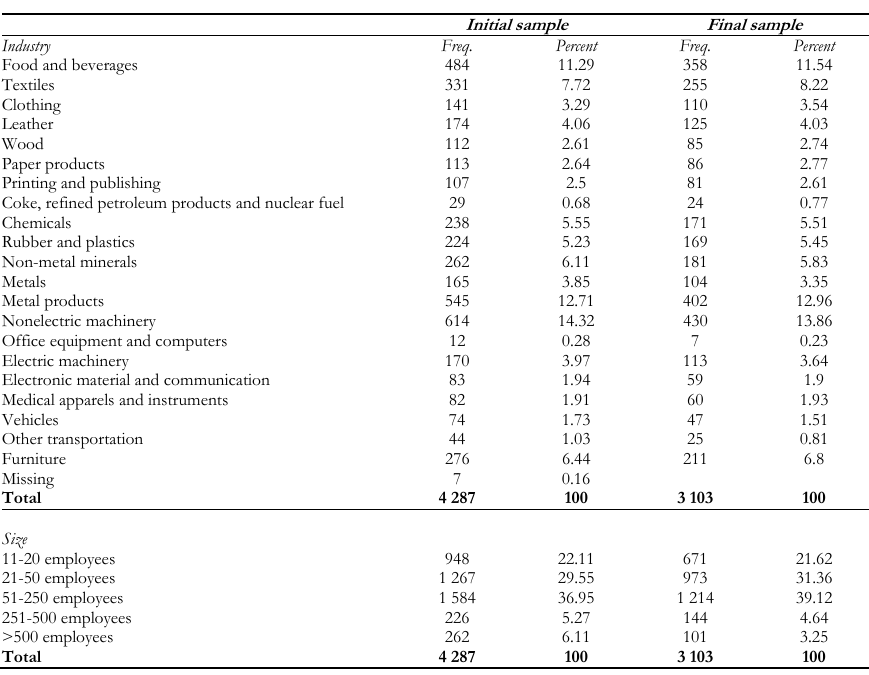
Distribution by industry and size, initial and final sample Initial sample Final sample Industry